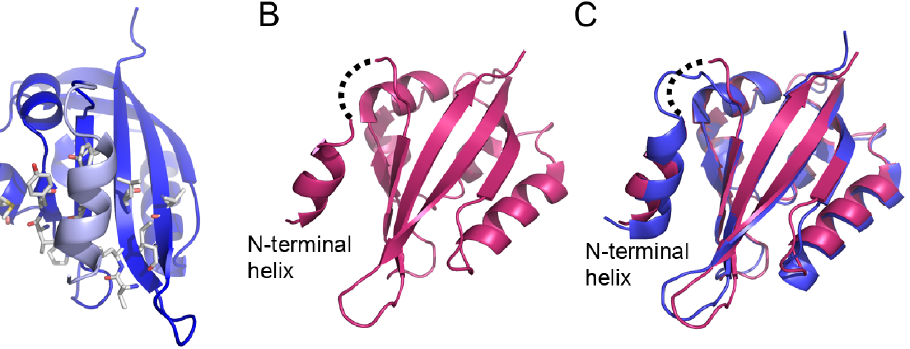
Figure 6. N-terminal helices in channel PAS domain structures. a) View of N-terminal helix (light blue) packed against hydrophobic patch of dELK PAS domain. Residues forming the patch are shown as stick. b) View of D 9-hERG PAS structure with N-terminal helix packed against the b -sheet. Dotted line represent a possible linker connection between N-terminal helix and the body of the D 9-hERG PAS domain. c) Superposition of structures of D 9-hERG PAS (redbrick) and dELK (blue). N-terminal helices are indicated. Dotted line as in b).